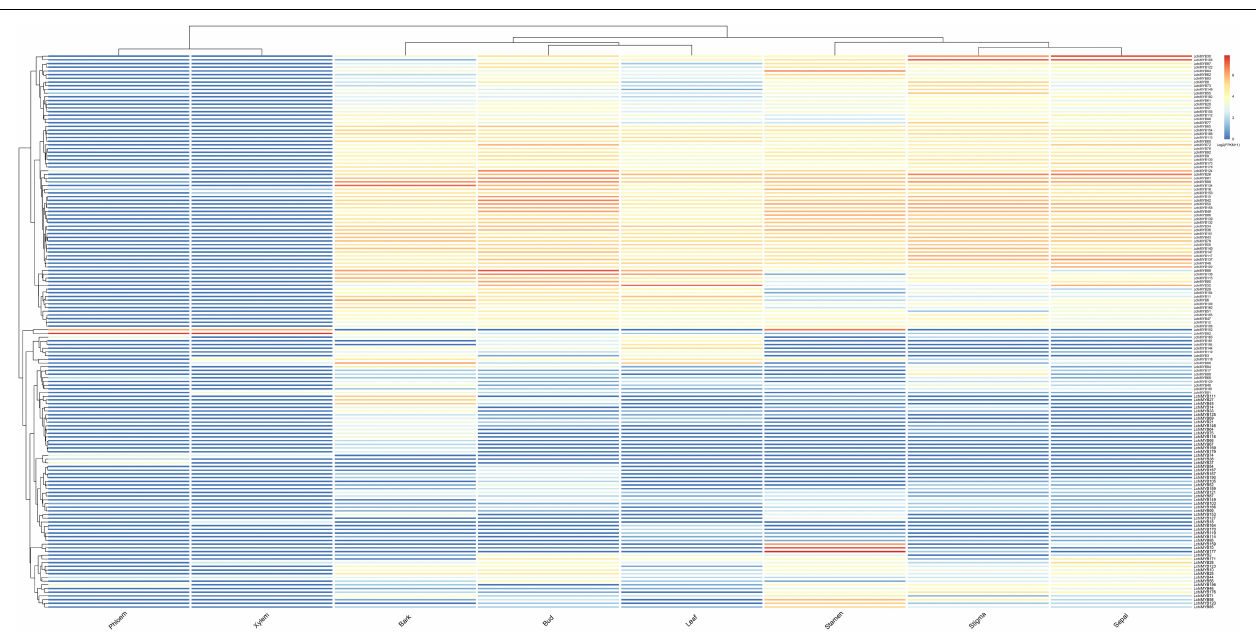
FIGURE 7 | The heatmap of FPKM values in eight different tissues. The phloem, xylem, stigma, bark, bud, leaf, stamen, stigma, and sepal represent the eight different tissues. The transcript abundance level was normalized and hierarchically clustered by using the log 2 (FPKM + 1) comparison among genes per tissue and different tissues. Colored blocks show decreased (blue) or increased (red) transcript accumulation at different stages. The color legend indicates the fold change expression of LchiMYBs , changing from low (blue) to high (red) expression. The heatmap was generated, using the R package “pheatmap” (v